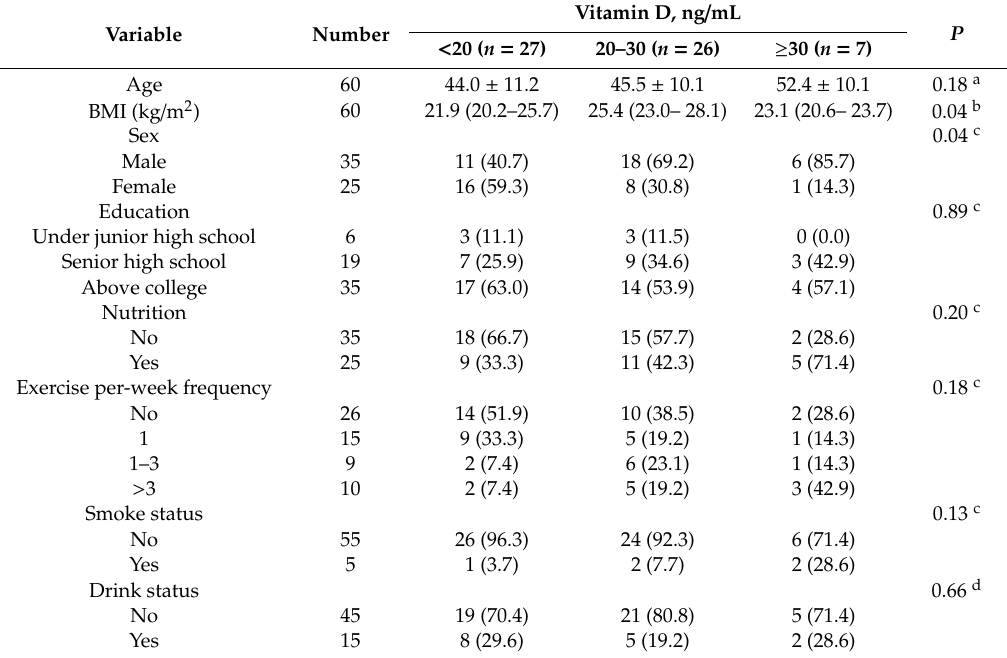
Table 1. Baseline characteristics of patients included in the